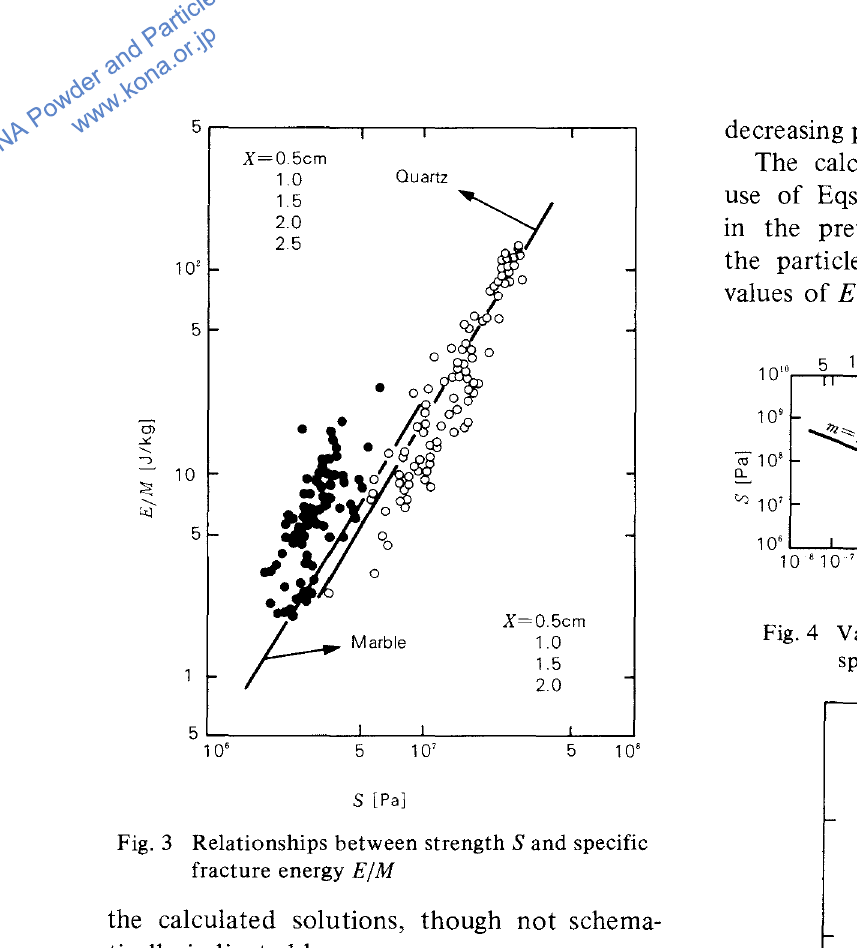
Fig. 3 Relationships between strengthS and specific fracture energy E/M